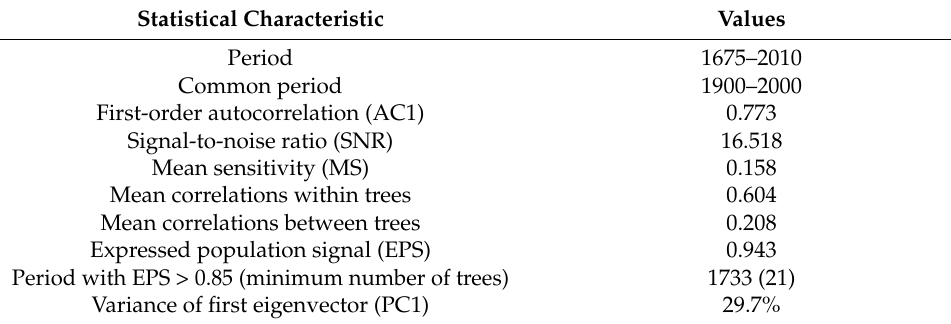
Table 1. Statistical characteristics of the chronology.